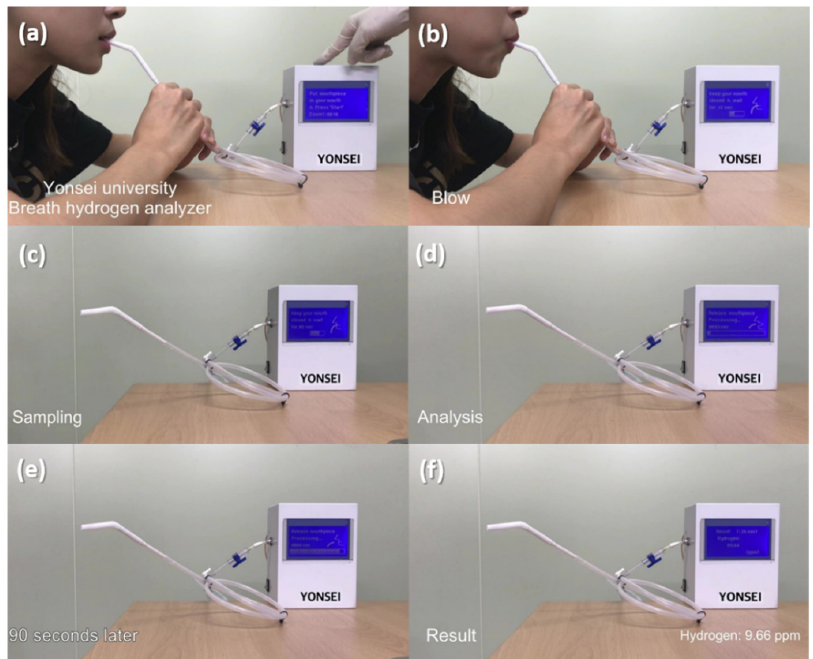
Figure 8. Real-time hydrogen gas sensing test via the manufactured hydrogen gas analyzer,